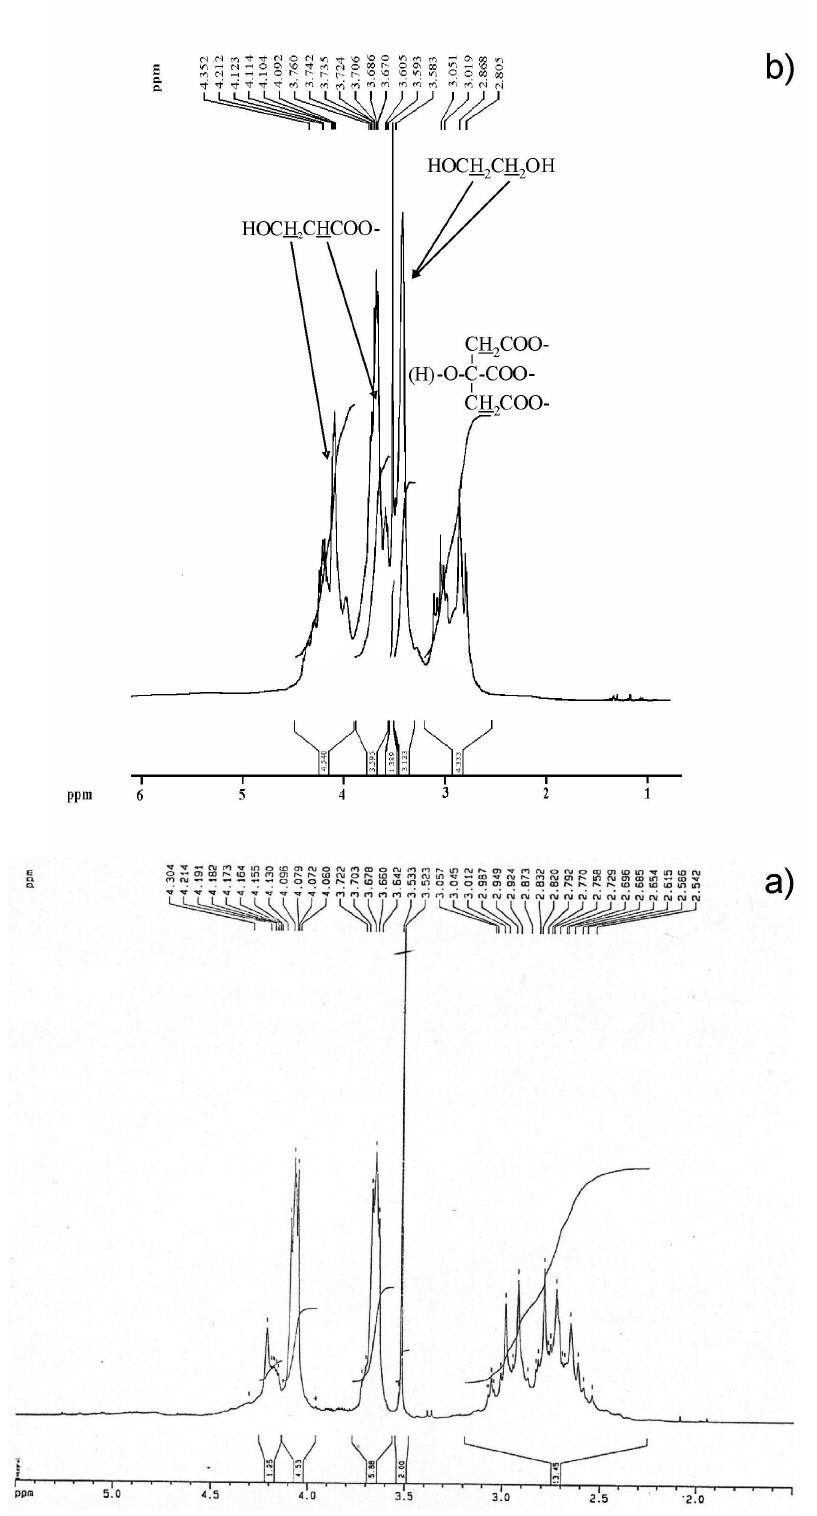
Fig. 3 1 H - NMR spectra of Al- (a) and Y-Al- (b) citric